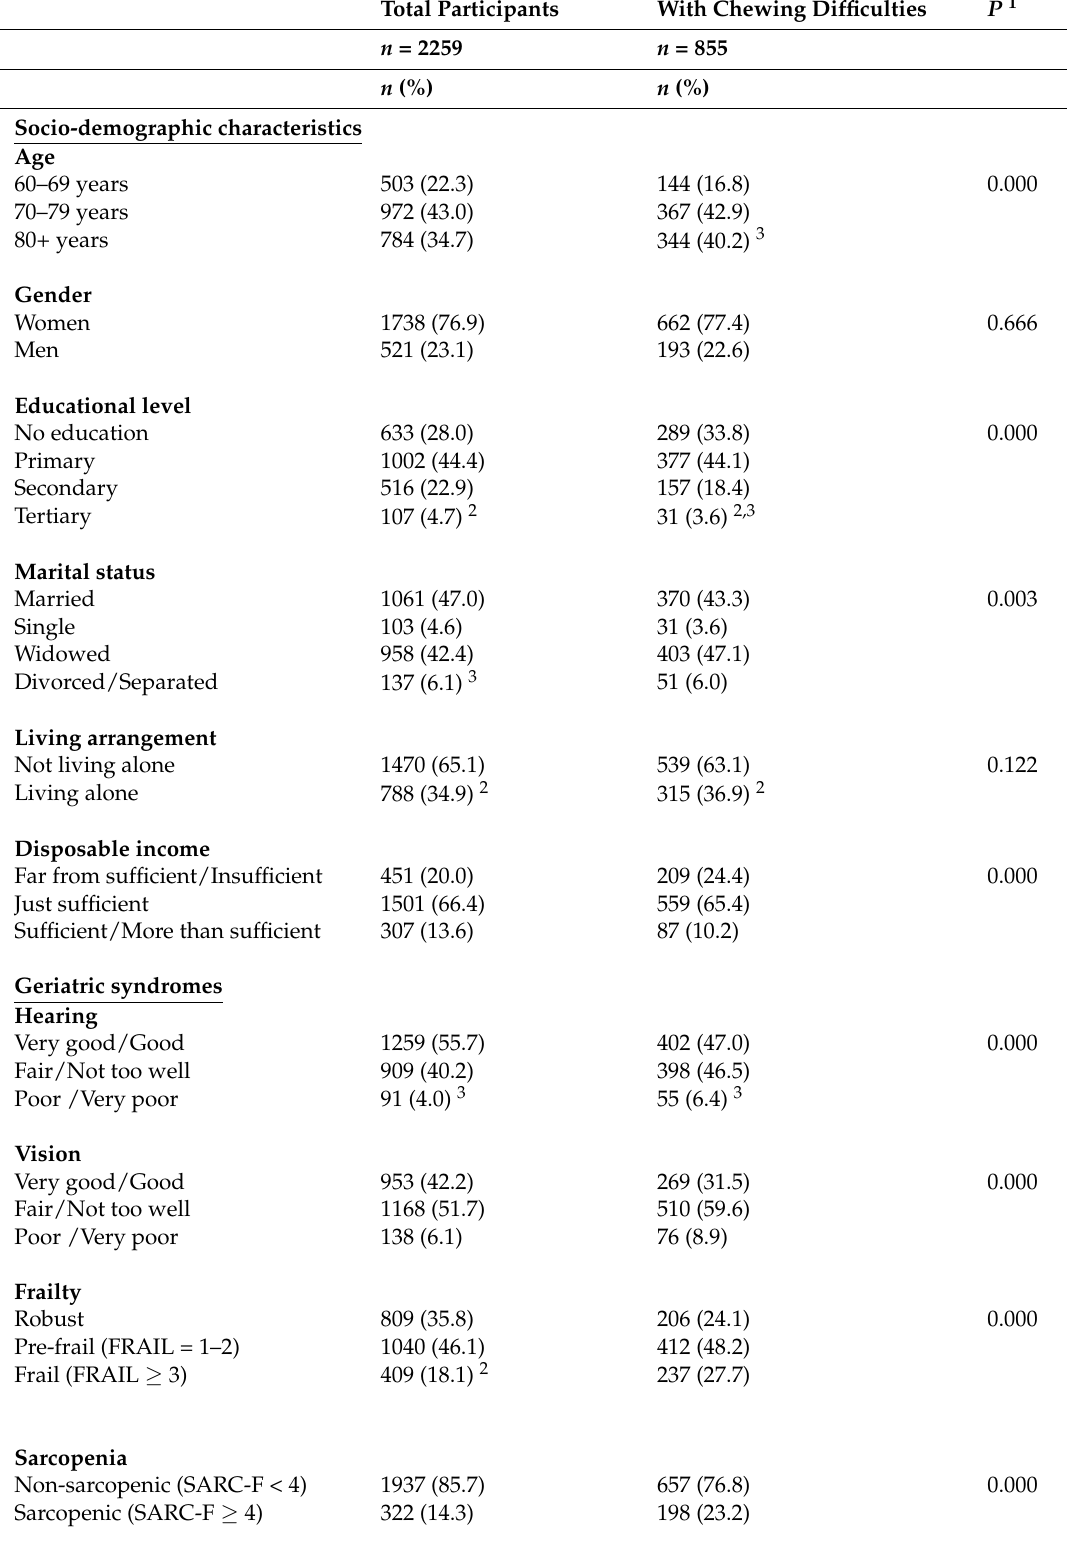
Table 1. Socio-demographic characteristics, geriatric syndromes, chronic diseases, number of medications, and use of health services at